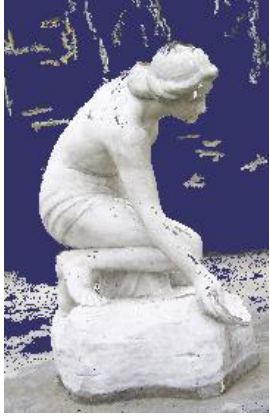
Figure 15. Results of point densification.